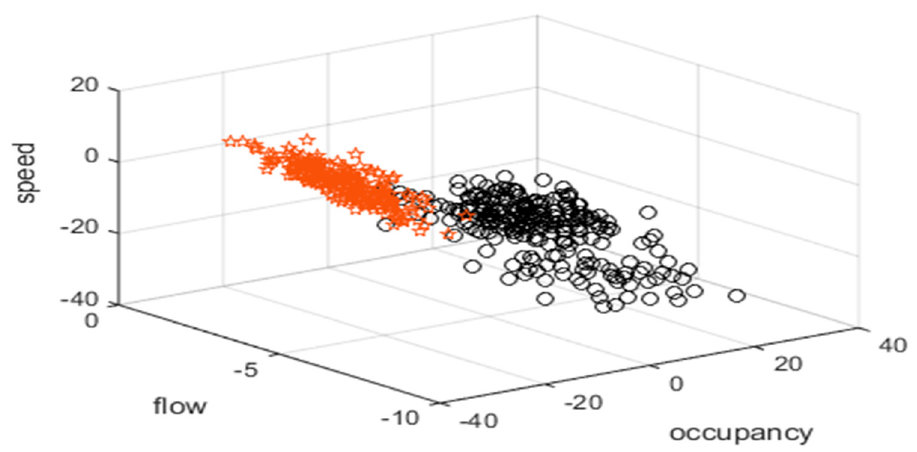
Table 3. Critical value in normalization processing in di ff erent time intervals.